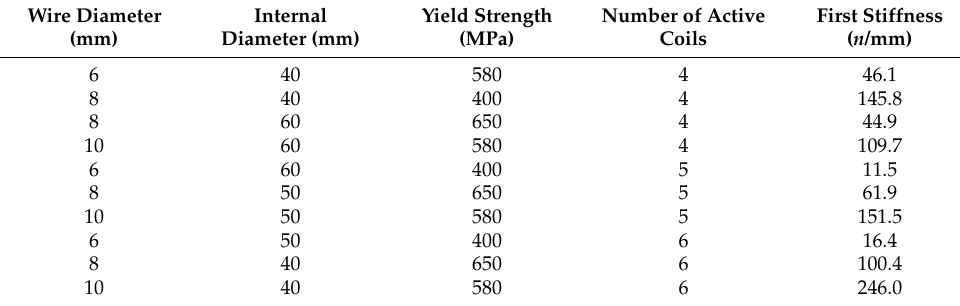
Table 3. Input and output patterns of